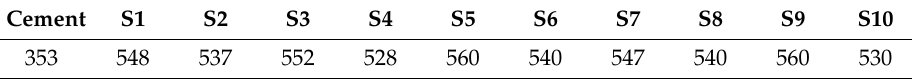
Figure 2. Particle size distribution of air quenched slags and cement. Table 4. The Blaine specific surface area of air quenched slags and cement (m 2 /kg).